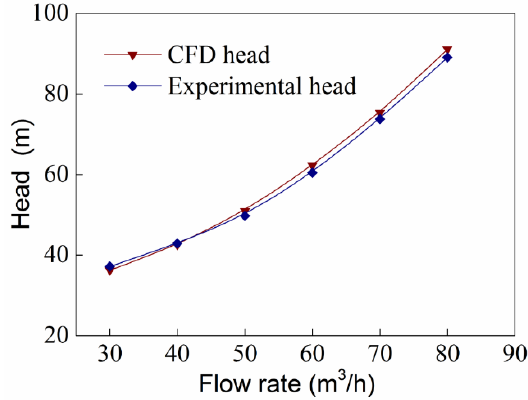
Figure 8. Comparison between experimental and numerical results.